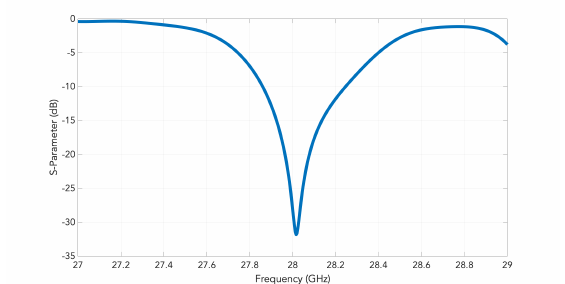
Figure 8. Simulated S 11 of the array of horns fed by the 2D transverse waveguide slot array.